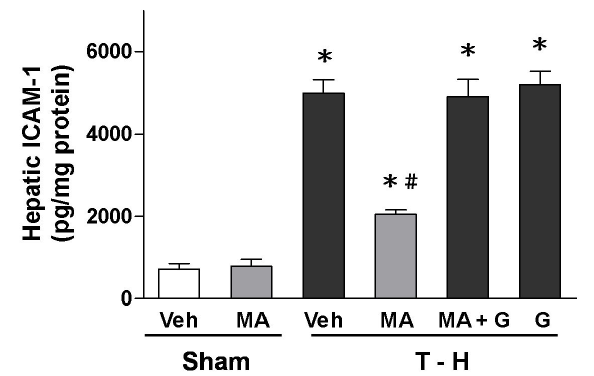
Figure 4. ICAM-1 levels in the liver in rats after sham operation (Sham) or trauma-hemorrhage and resuscitation (T-H). Animals were treated with vehicle (Veh), maraviroc (MA), maraviroc in combination with GW9662 (MA+G) or GW9662 (G). Data are shown as mean ± SEM of 8 rats in each group. * p <0.05 compared to Sham; # p <0.05 compared to T-H +Veh, T-H+MA+G, and T-H+G. doi: